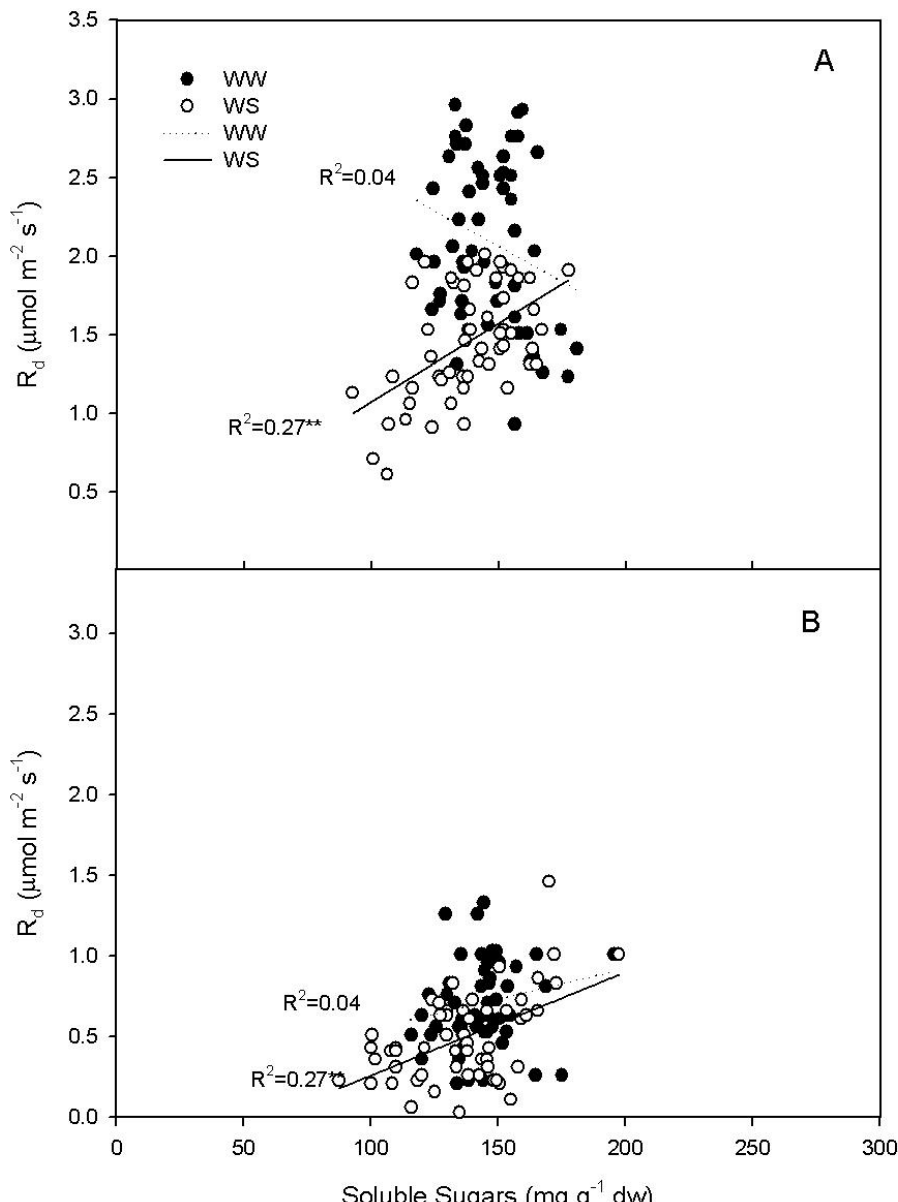
Figure 5. Relationship between leaf dark respiration (R d ) and leaf soluble sugars in well-watered (WW) and water stressed (WS) vines at ( A ) midday (y = 3.40 − 8.87x, R 2 = 0.06 p = 0.07; y = 0.07 + 10.01x, R 2 = 0.27 p < 0.0001, respectively) and ( B ) at 4:00 a.m. (y = 0.17 + 3.75x, R 2 = 0.04 p = 0.15; y = − 0.37 + 6.39x, R 2 = 0.27 p < 0.0001, respectively). * indicates p < 0.05; ** indicates p < 0.0001.